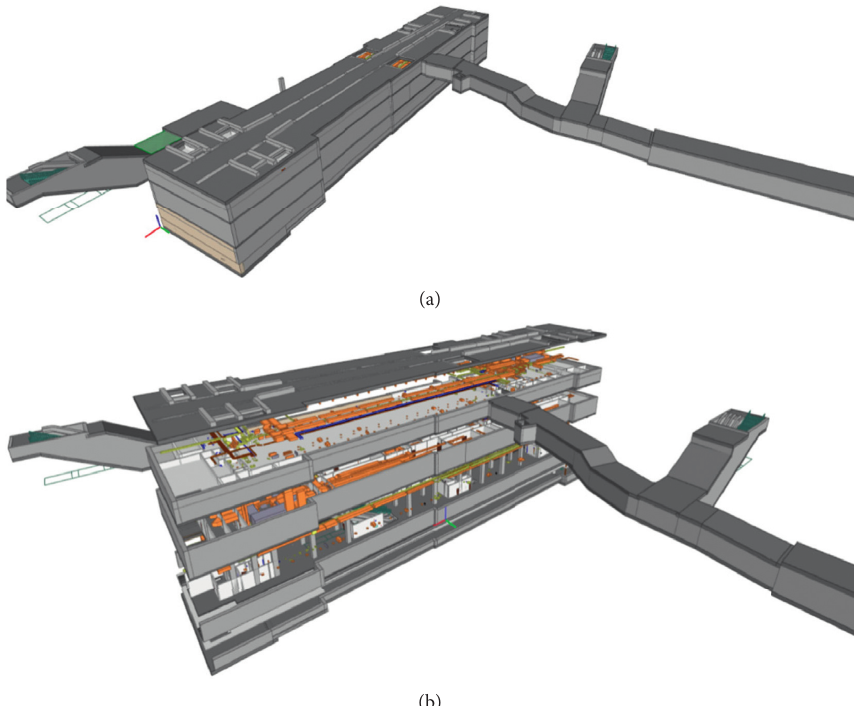
Figure 16: The metro